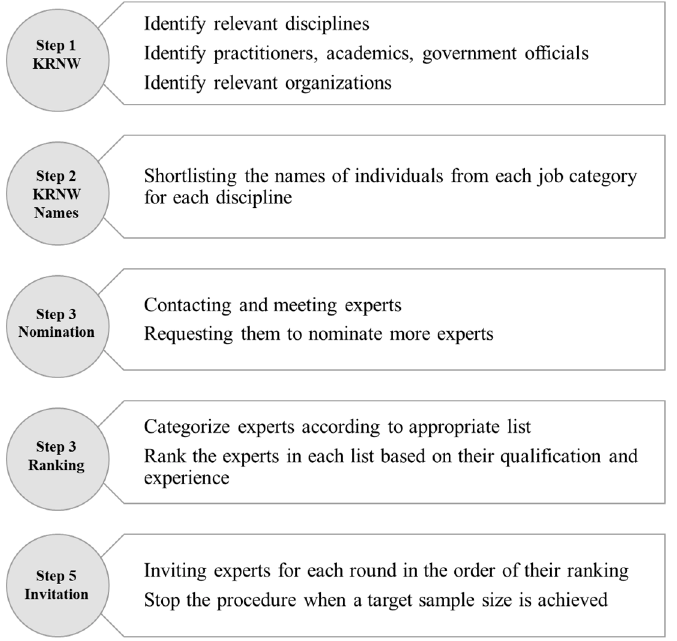
Figure 6. Procedure for Selecting Experts in Delphi Technique.